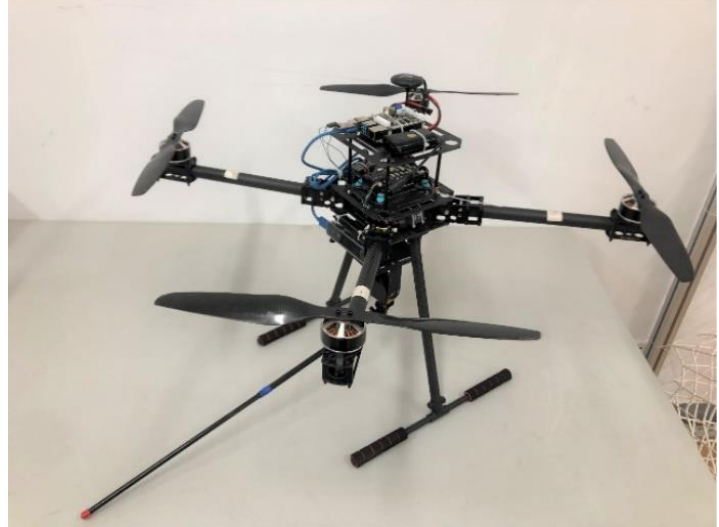
Figure 17. The UAM system.